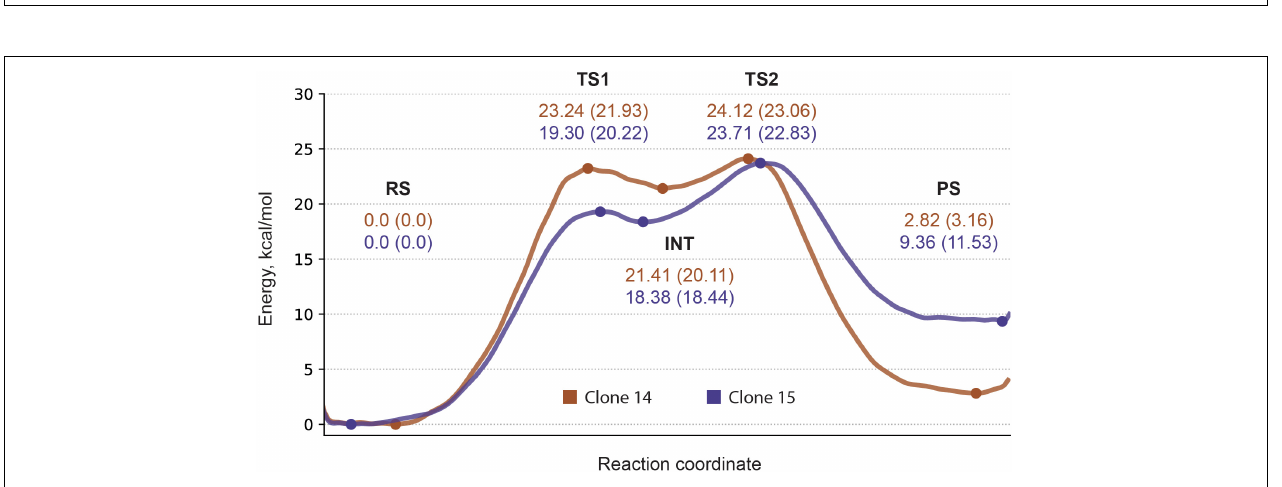
FIGURE 5 | Energy profile for clones 14 and 15. Metadynamics profile shown in solid line. Reported are energy values for reaction states with PBE0 calculations shown in parentheses.